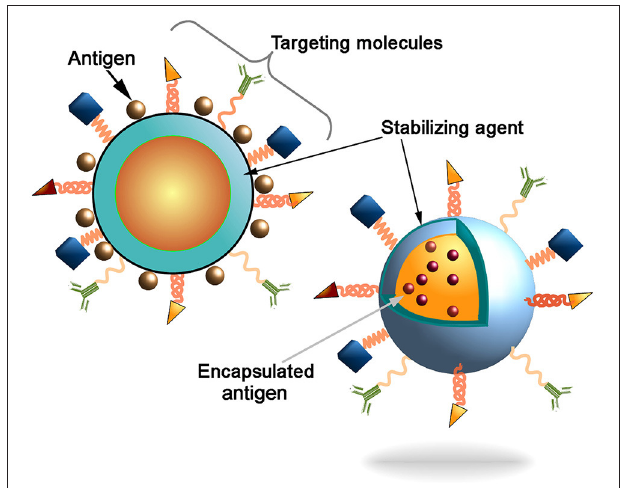
FIGURE 1 | Schematic representation of the nanocarriers. Antigen can be conjugated to the nanoparticles surface or incapsulated into core of the particles. Decoration of the nanoparticles surface with targeting molecules (e.g., antibodies, Fab-fragments, peptides, etc) could further increase the delivery of particles into the antigen presenting cells (APCs) to induce innate and adaptive immune